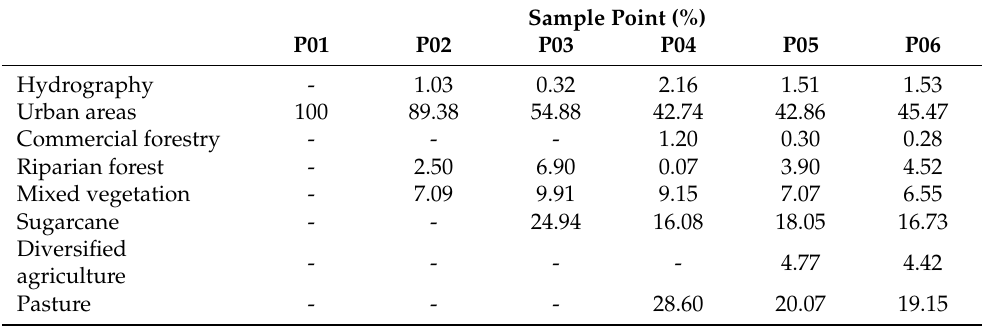
Table 2. Land uses in the micro-basin